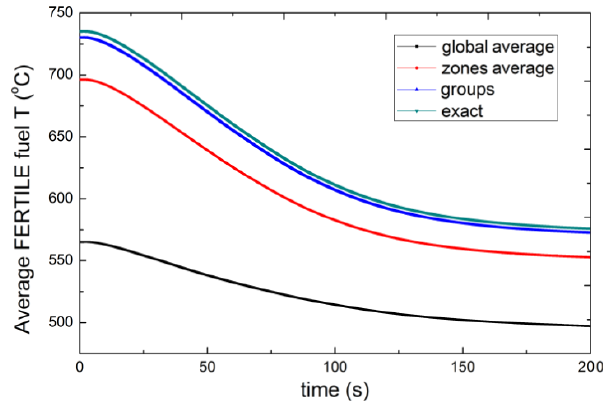
Fig. 11. Average fertile temperature during ULOF/PP for different H gap treatments.